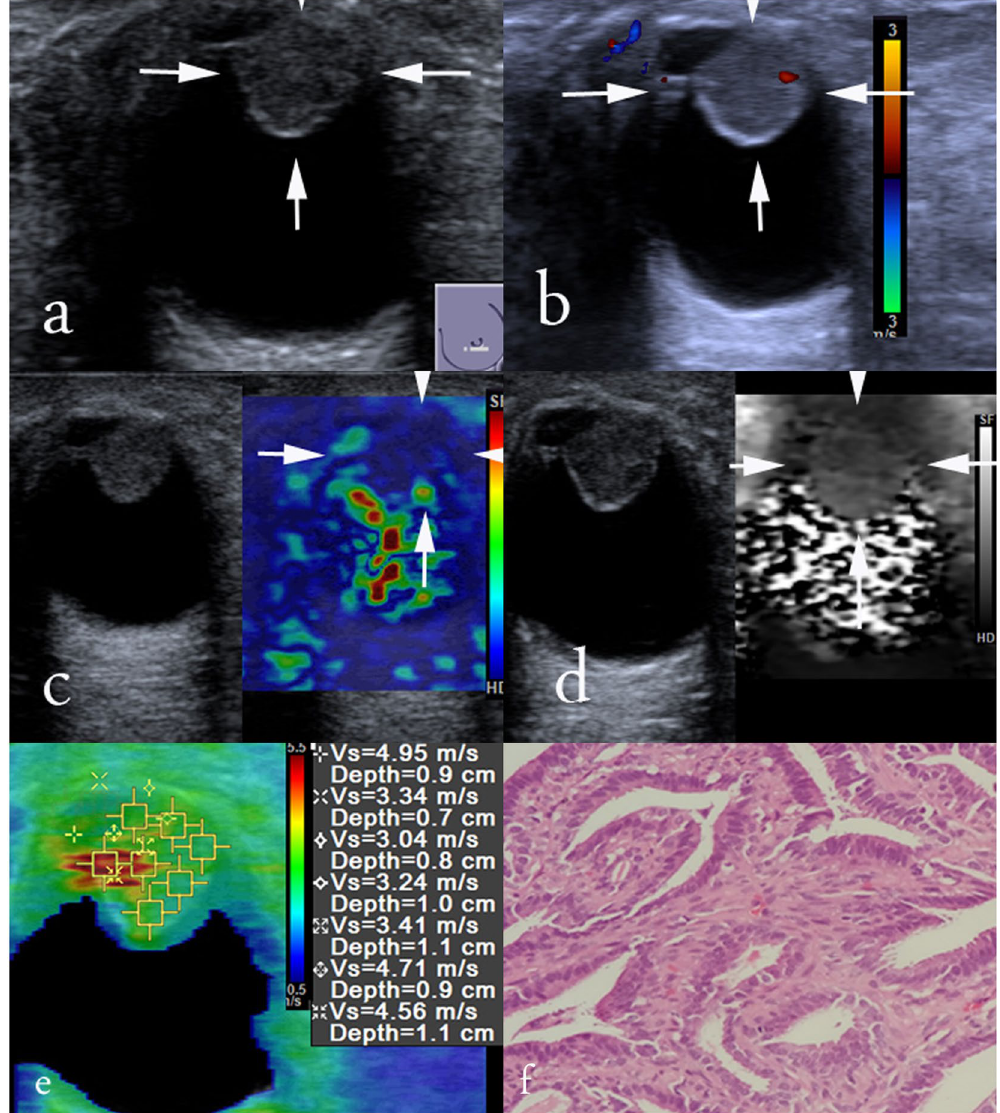
Figure 1. Images in a 45-years-old woman with intraductal papilloma. At conventional US, an 19-mm breast lesion at 6 o’clock position of the left breast appears to be predominately cystic, round in shape, not parallel in orientation, circumscribed in margin, hypoechogenicity, enhancement in posterior acoustic features, absence of internal vascularity and calcification, and was finally classified as BI-RADS category 4a, ( a ) and ( b ). At elastography, SE score of 3 ( c ), pattern 3 in VTI ( d ), and SWS max of 4.95 m/s, SWS median of 3.41 m/s, SWS mean of 3.89 m/s, SWS min of 3.04 m/s ( e ) are obtained. Histologic specimen (hematoxylin-eosin stain; original magnification, × 100) confirms a diagnosis of intraductal papilloma ( f